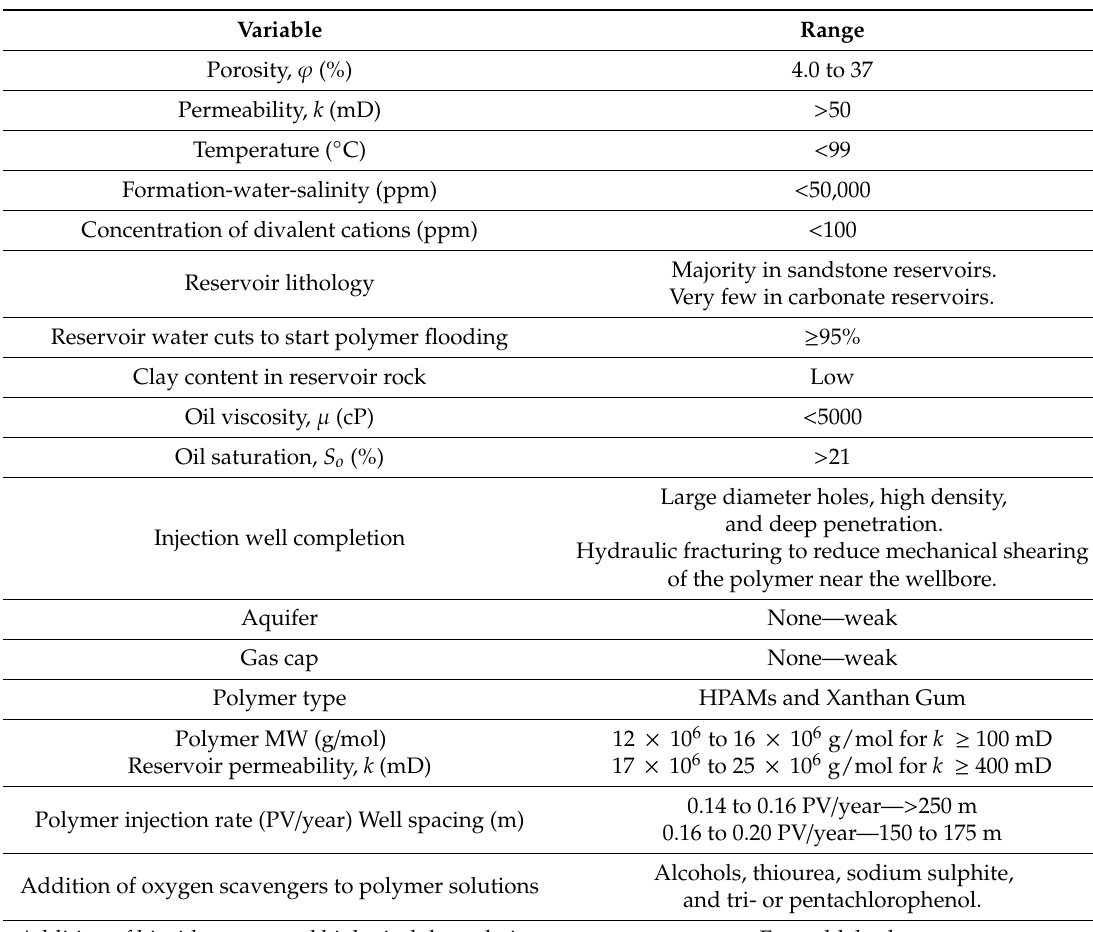
Table 5. Range of variables: field applications of polymer flooding